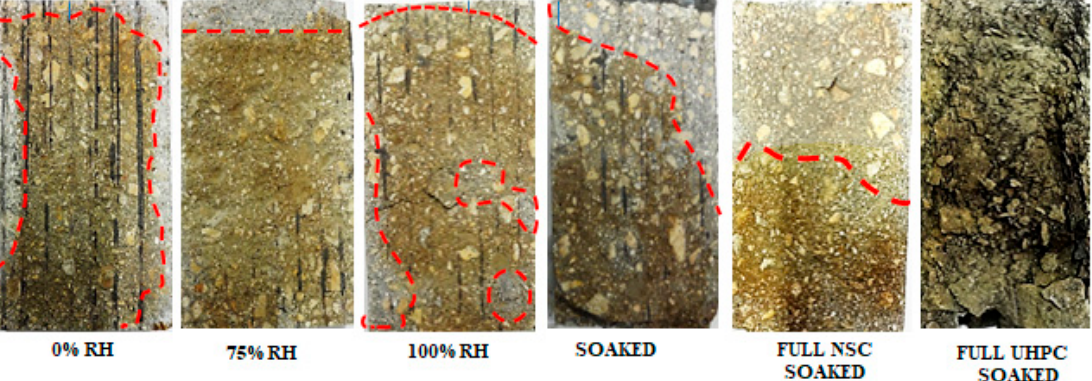
Figure 6. Representative sample for differential chloride penetration. Table 3. Average penetration depth for composite